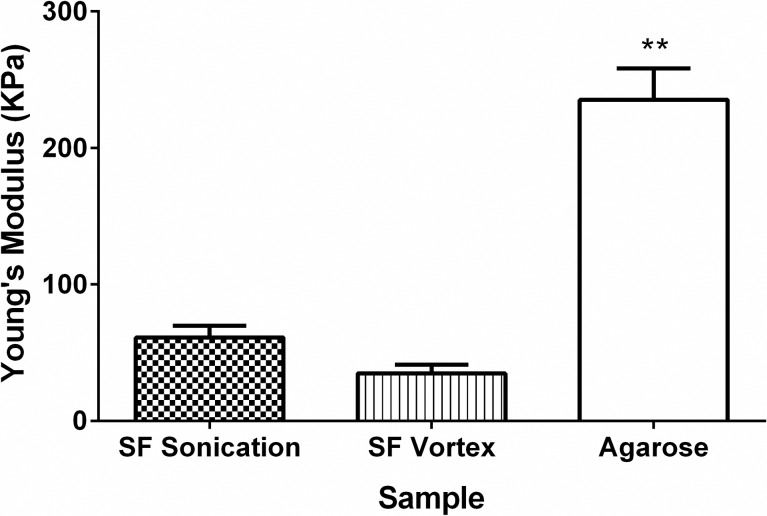
Young’s modulus of samples after mechanical testing.Error bars indicate standard deviations of triplicate measurements. Kruskal-Wallis test. **p<0.01.